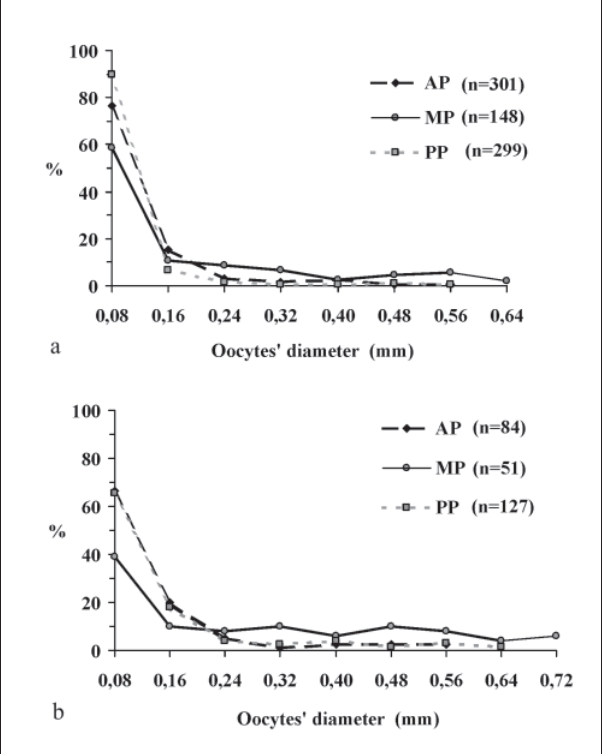
Fig. 14a-b – Distribution of the relative frequency of the oocytes’ diameter of the anterior (AP), medium (MP) and posterior (PP) portions of gonads of two ripe females of Mycteroperca